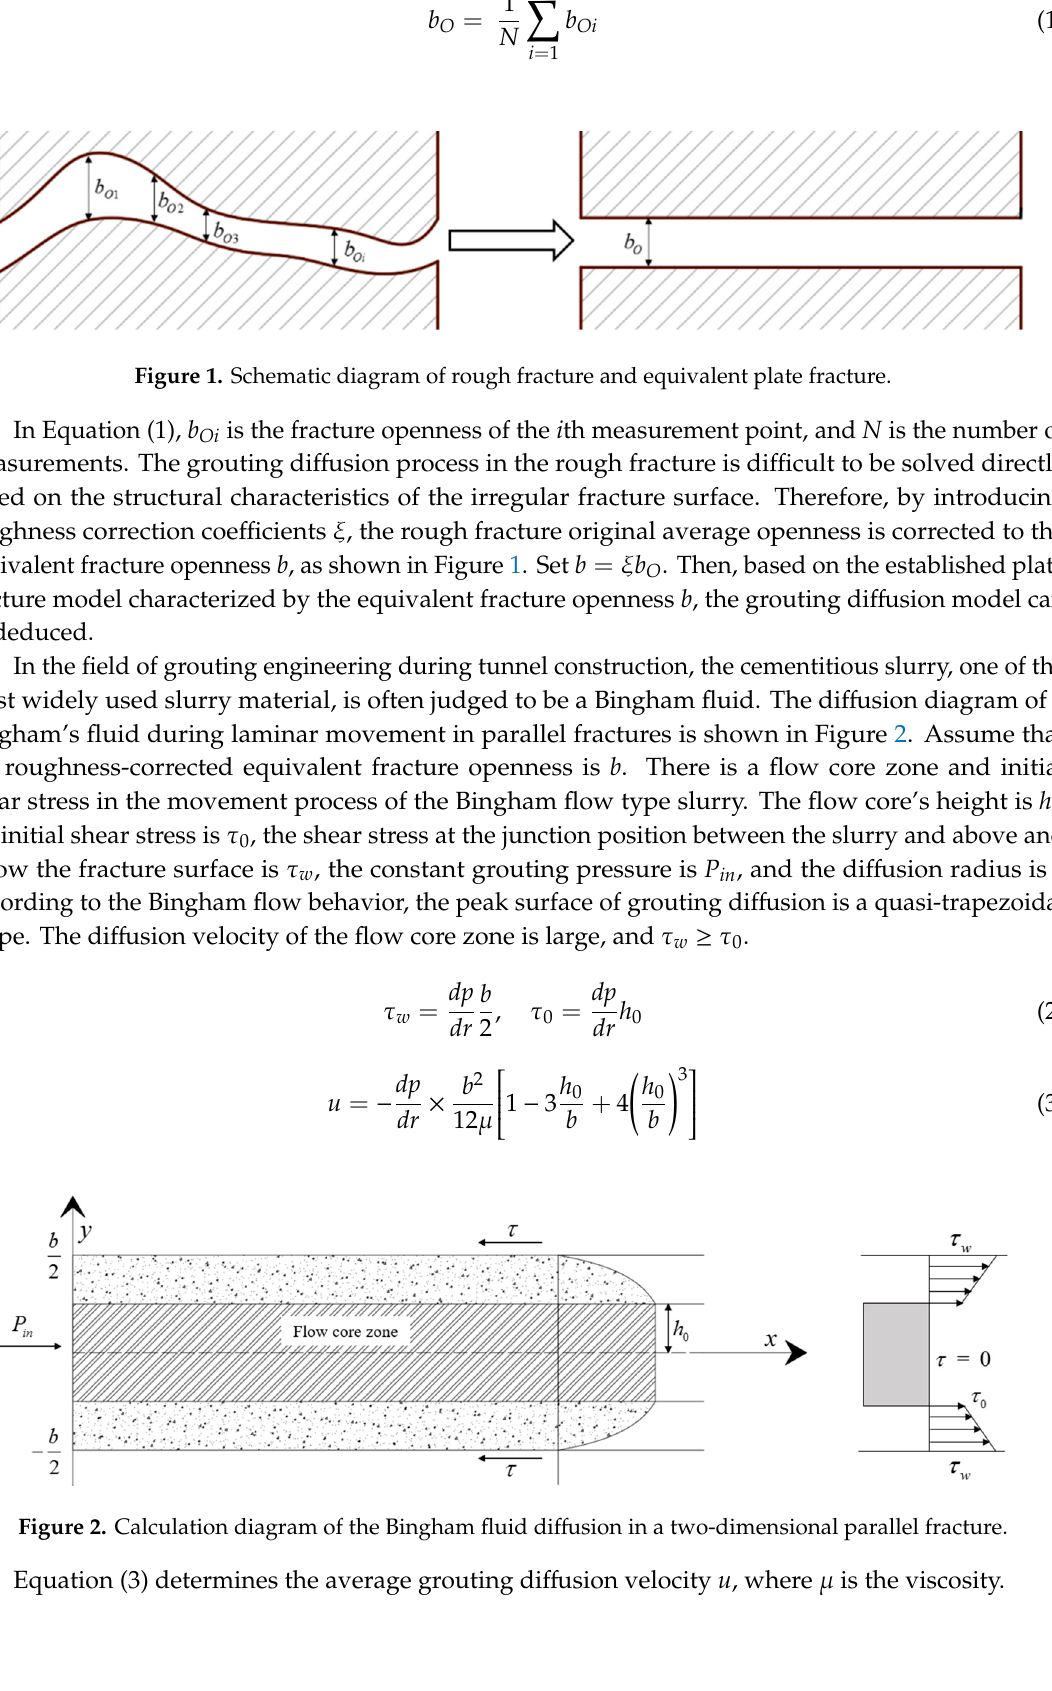
Figure 2. Calculation diagram of the Bingham fluid diffusion in a two-dimensional parallel fracture.